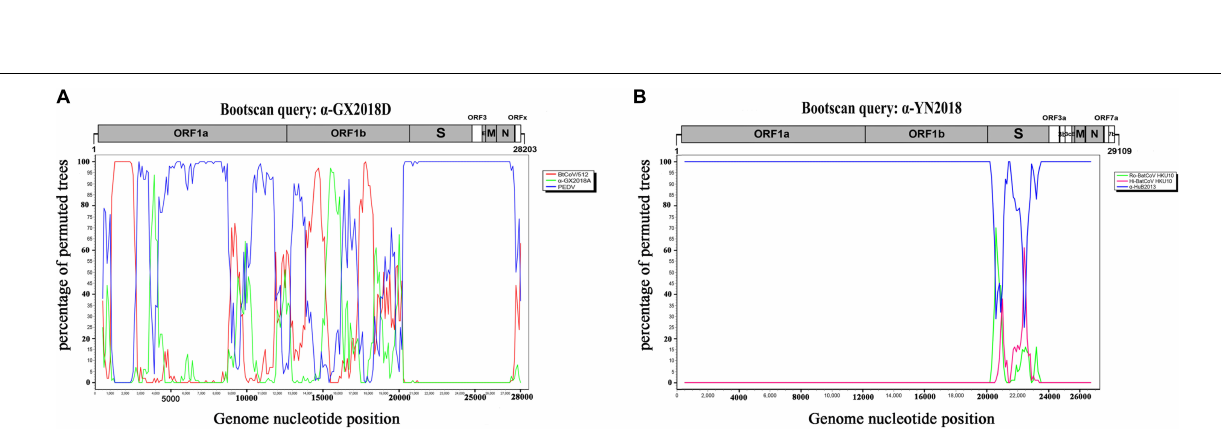
FIGURE 5 | Detection of potential recombination events by bootscan analysis. (A) Full-length genome sequence of α -GX2018D was used as a query sequence and BtCoV/512, α -GX2018A, and PEDV as reference sequences. (B) Full-length genome sequence of α -YN2018 was used as a query sequence and Ro-BatCoV HKU10, Hi-batCov HKU10, and α -HuB2013 as reference sequences. All analyses were performed with a Kimura model, a window size of 1000 base pairs, and a step size of 100 base pairs. The gene map of query genome sequences is used to position